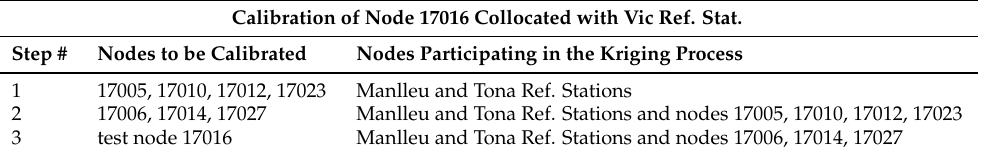
Table 6. Multi-scale calibration with Kriging estimates (Captor node